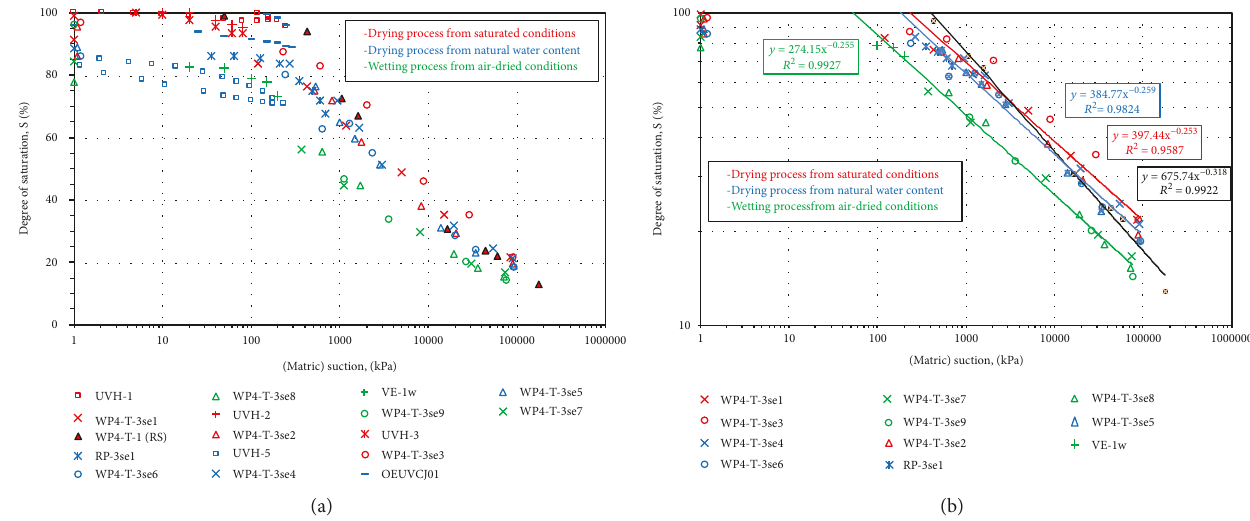
Figure 6: Drying and wetting paths of the SWCC- S at (a) semilog and (b) log-log